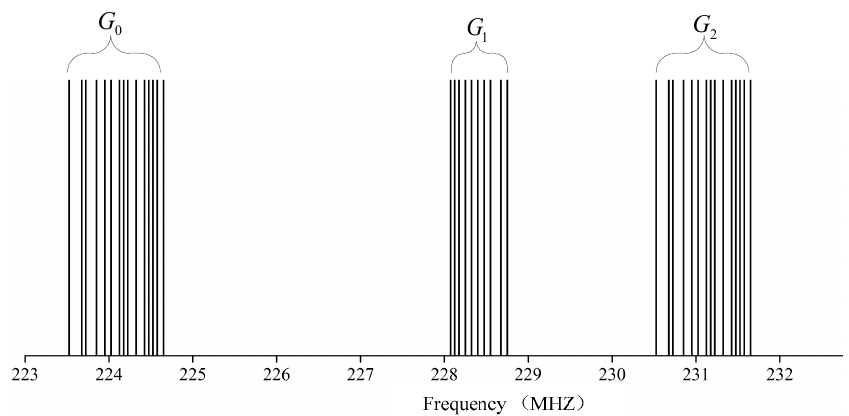
Figure 2. Illustration of the state grid licensed spectrum at 230 MHz.